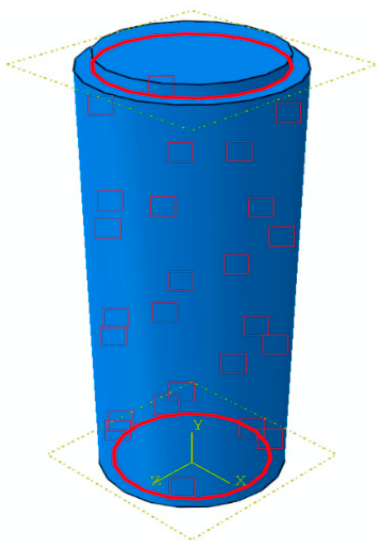
Figure 9. Loading and boundary conditions.